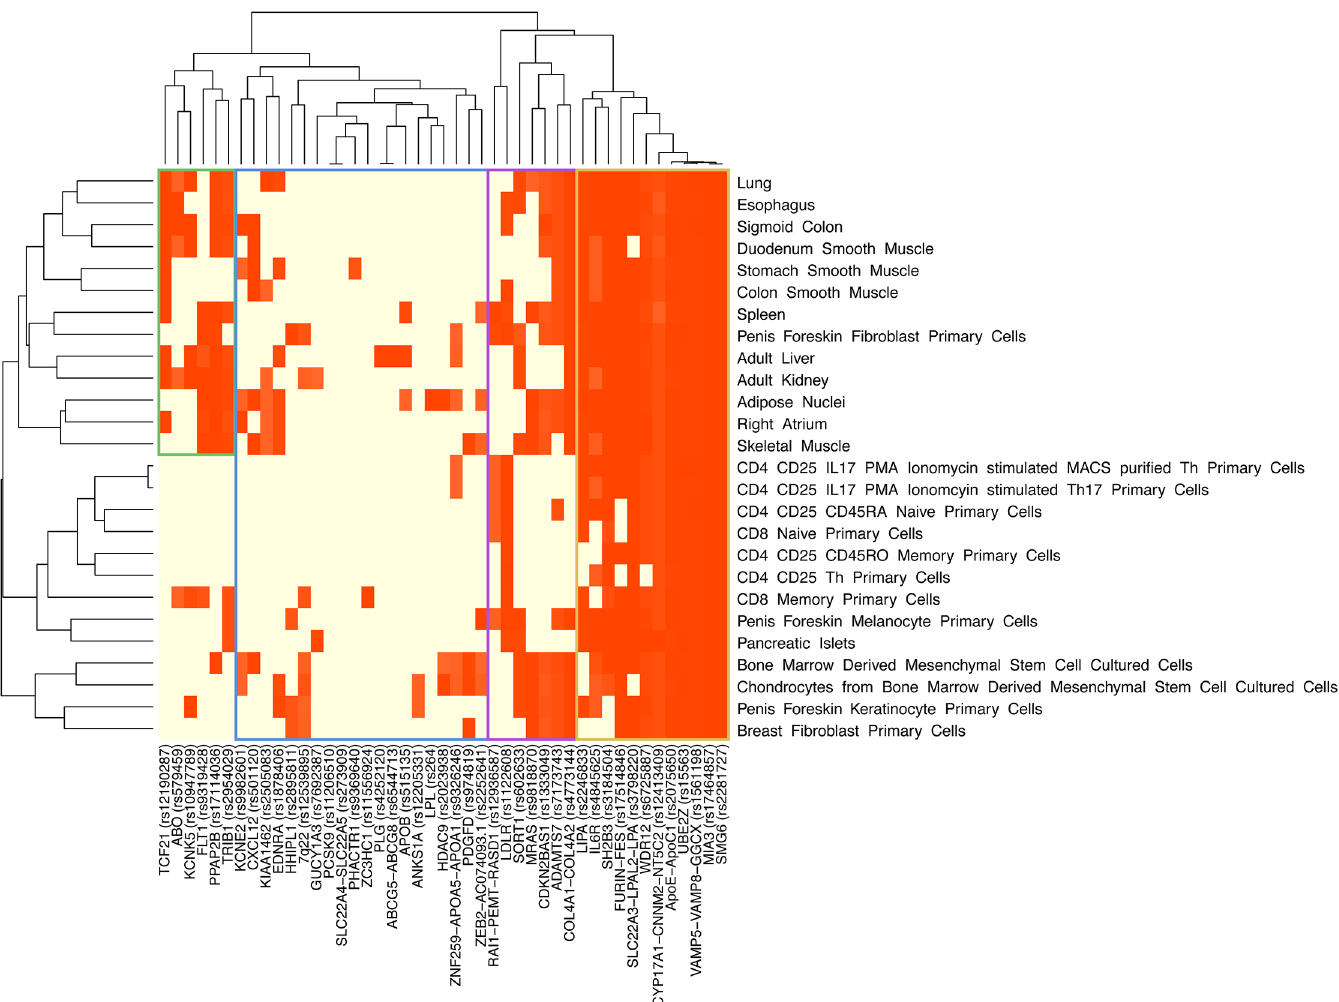
Fig 3. Hierarchical clustering of 45 MI/CAD GWAS SNPs and specific cell types for a histone modification mark (H3K27ac). We mapped 45 MI/CAD GWAS SNPs, as well as SNPs in high linkage disequilibrium ( r 2 (cid:2) 0.8), to H3K27ac in different cell types. Hierarchical clustering was based on the presence or absence of a SNP residing in H3K27ac in different cell types and was performed using the heatmap function in R (R Project for Statistical Computing). We observed unique patterns between the different GWAS loci and cell types. For example, 12 of the 45 GWAS loci were expressed in more than 80% of the cell types, whereas 13 of the 45 GWAS loci were expressed in less than 20%. Red color indicates a lead SNP or tag SNPs (linkage disequilibrium value of r 2 (cid:2) 0.8) residing in H3K27ac in different cell types (See S9 and S10 Figs for H3K9ac and H3K4me3, respectively). MI, myocardial infarction; CAD, coronary artery disease; GWAS, genome-wide association study; SNP, single nucleotide